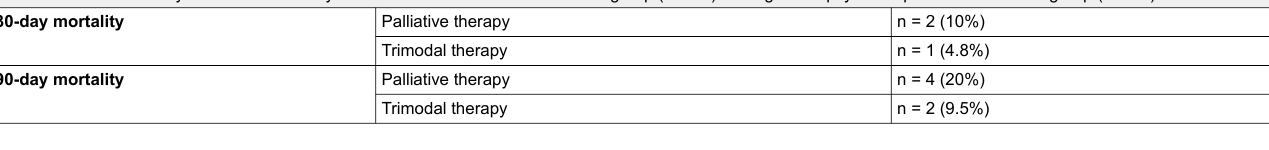
Table 4: Overall mortality after 30 and 90 days after EPP in the trimodal treatment group (n = 21) or surgical biopsy in the palliative treatment group (n = 20).